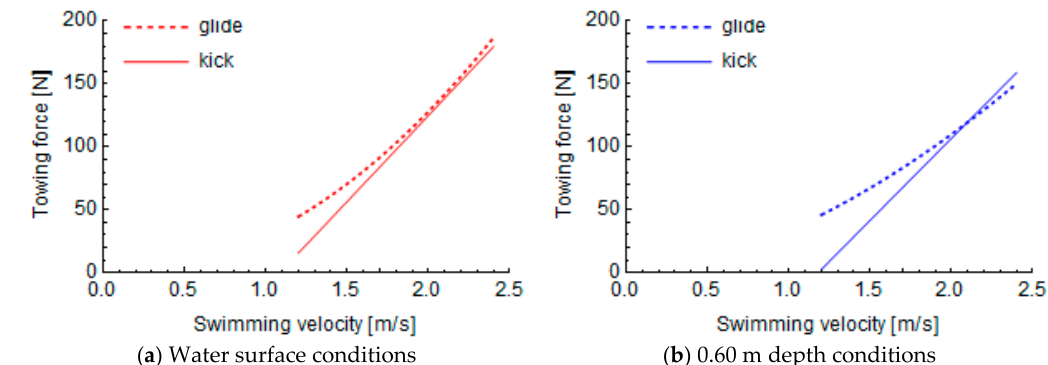
Figure4. A relationship between towing velocity and force in the glide and kick trials in case of a